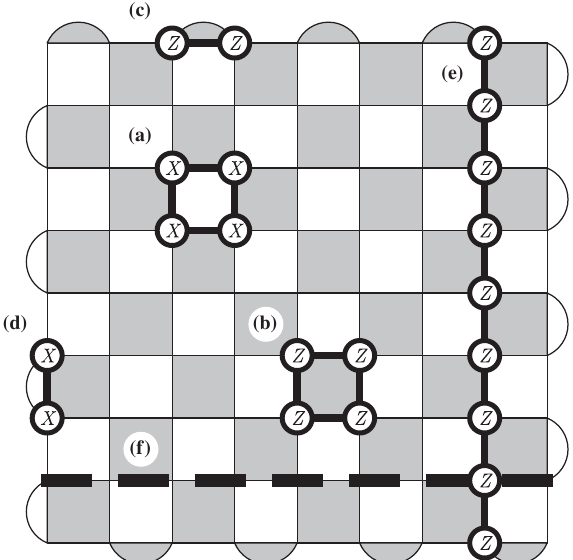
FIG. 1. The planar variant of the surface code with two rough boundaries and two smooth boundaries. Qubits lie on the vertices of the square lattice. Diagrams (a) and (b) show the two different types of weight-four stabilizer operators. Diagrams (c) and (d) show two stabilizers that lie at the boundary of the lattice. ¯ Z (e) The logical operator is the tensor product of Pauli- Z operators extending from the top to the bottom of the lattice. ¯ X (f) The logical operator is the tensor product of Pauli- X operators along the horizontal dashed line that extends from the left to the right of the